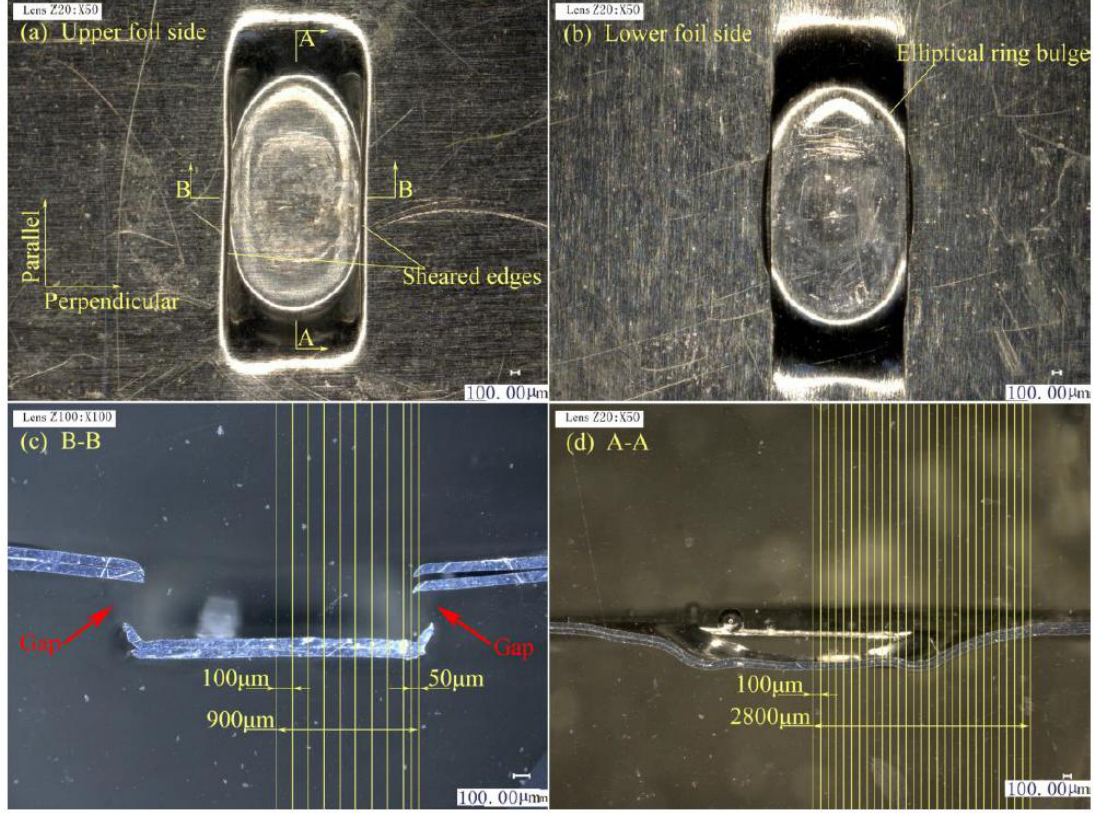
Figure 12. Preliminary joint formation in Stage 2: ( a ) upper foil side appearance; ( b ) lower foil side appearance; ( c ) B–B section on perpendicular symmetry plane; and ( d ) A–A section on parallel symmetry plane.